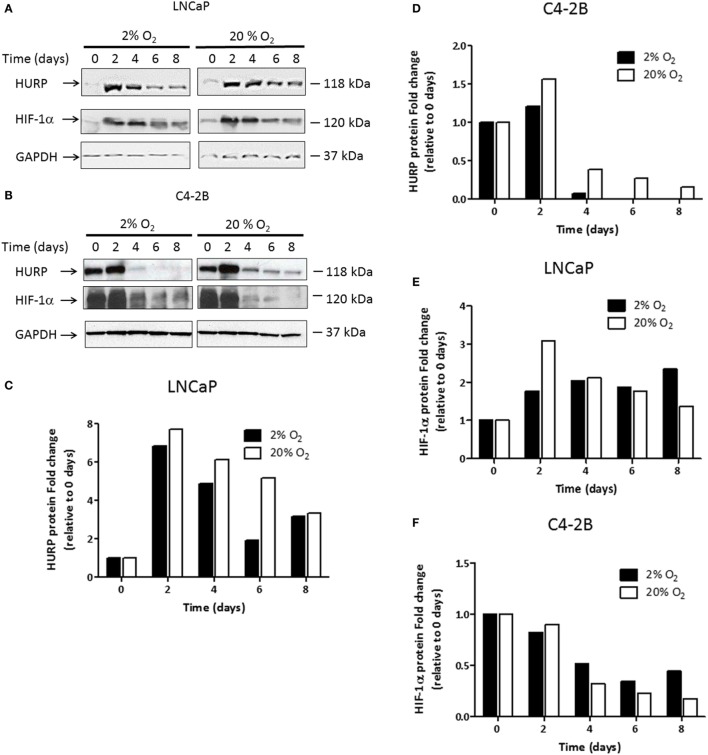
Assessment transcripts of hypoxia-responsive genes: prostate cancer cells were cultured under hypoxia or normoxia during the indicated time intervals. Protein lysates were prepared and 50 μg of the total protein was fractionated on the 12% SDS-PAGE, blotted onto the nitrocellulose membrane, and tested against antibodies. Western blot analysis using anti-hepatoma upregulated protein (HURP), hypoxia-inducible factor 1-alpha (HIF-1α), and glyceraldehyde-3-phosphate dehydrogenase (GAPDH) antibodies in (A) LNCaP cells and (B) C4-2B cells. The relative intensities of the bands under hypoxia (■) or normoxia (□) were quantified using the ImageJ software, and all the values were normalized to the intensities of the respective GAPDH signal. Data are expressed as the fold change obtained after dividing the optical density of HURP (C,D); and HIF-1α (E,F) proteins for a given cell line and time point, relative to the OD observed of the respective protein under the corresponding value at 0 days.